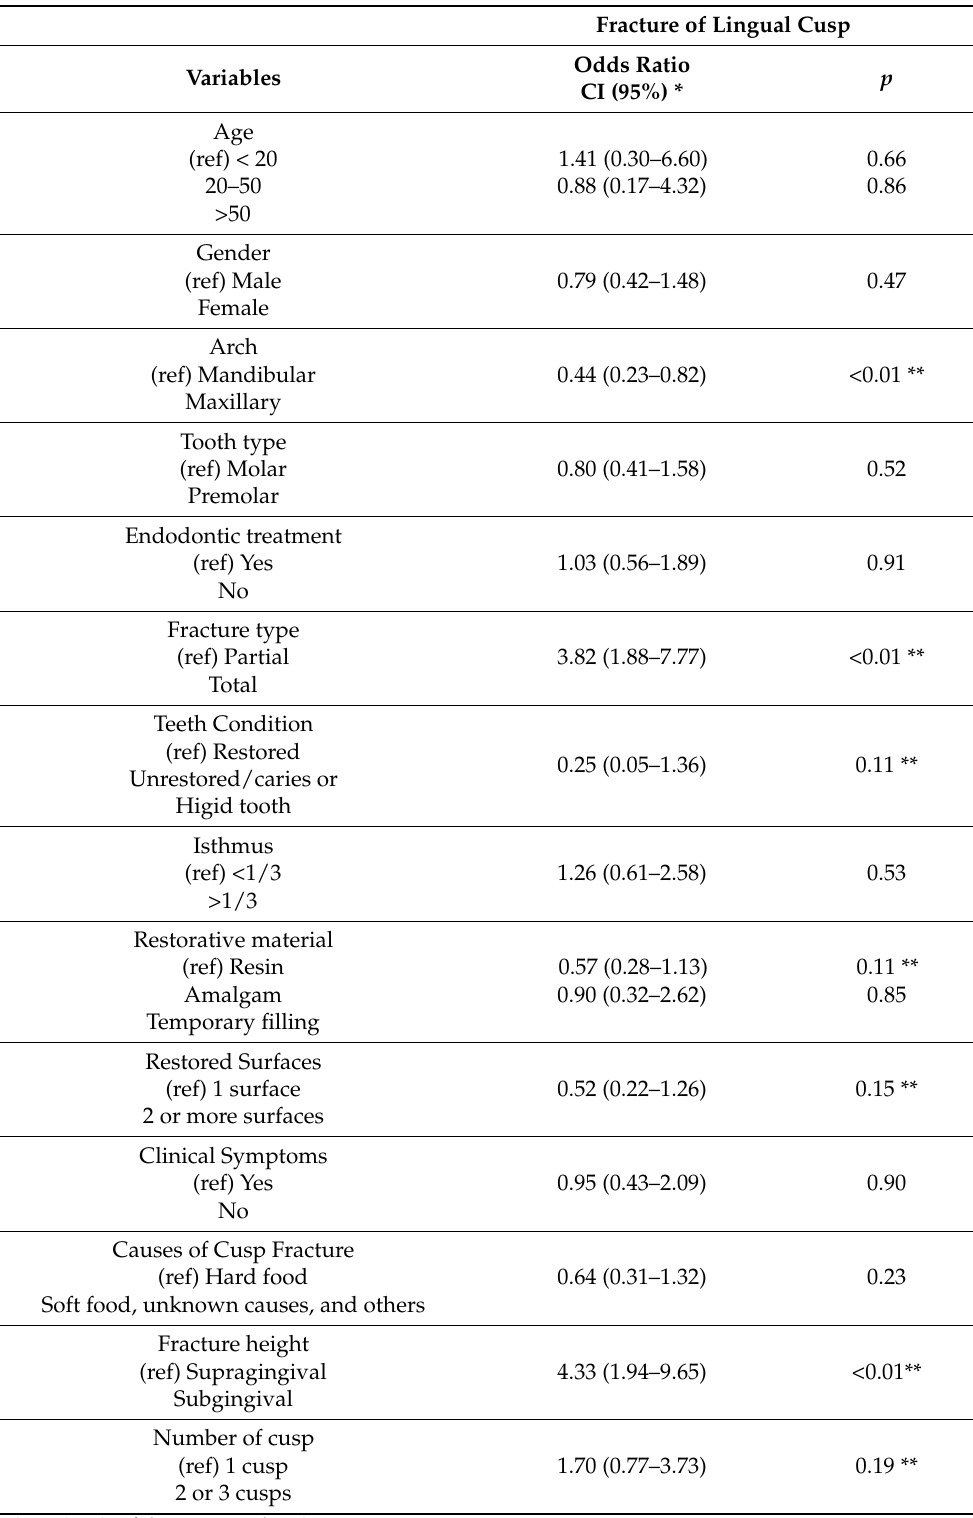
Table 2. Univariate logistic regression correlated with the fracture of the lingual